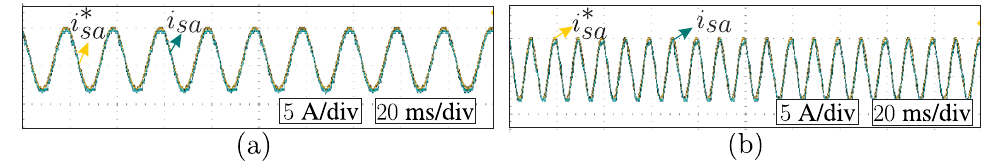
Figure 15. Current tracking performance. i ∗ sa = 4 A, ( a ) f = 50 Hz ( b ) f = 100 Hz.